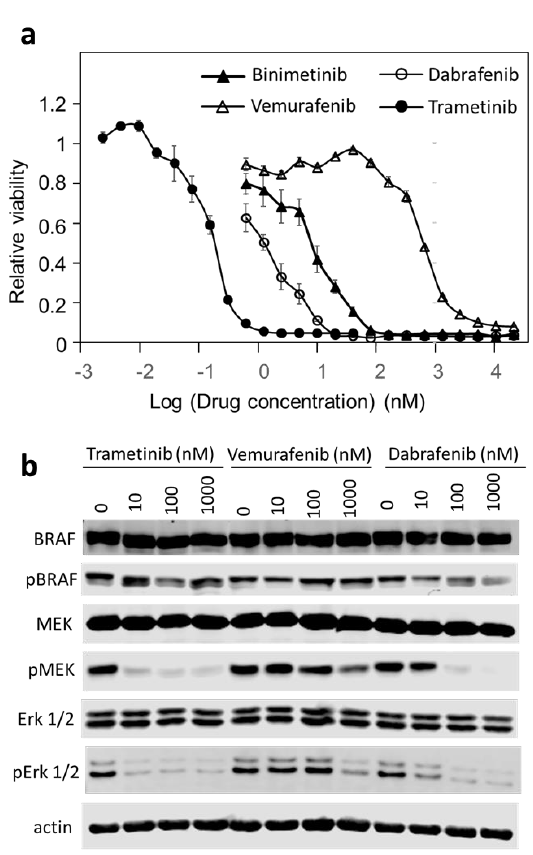
Figure 2. Effects of BRAF and Mek kinase inhibitors on the viability and the MAPK pathway signaling. ( a ) Dose-dependent inhibition of DU-4475 cell viability by BRAF (dabrafenib and vemurafenib) and Mek (binimetinib and trametinib) kinase inhibitors. The reported values are the average of six wells from two triplicate assays and standard error. ( b ) Western blots of BRAF, Mek and Erk total protein and phosphorylation status in DU-4475 cells after the cells were treated with indicated drugs for 1 h. β -actin was used as a loading control. Uncropped Western Blots and densitometry can be found at supplementary.